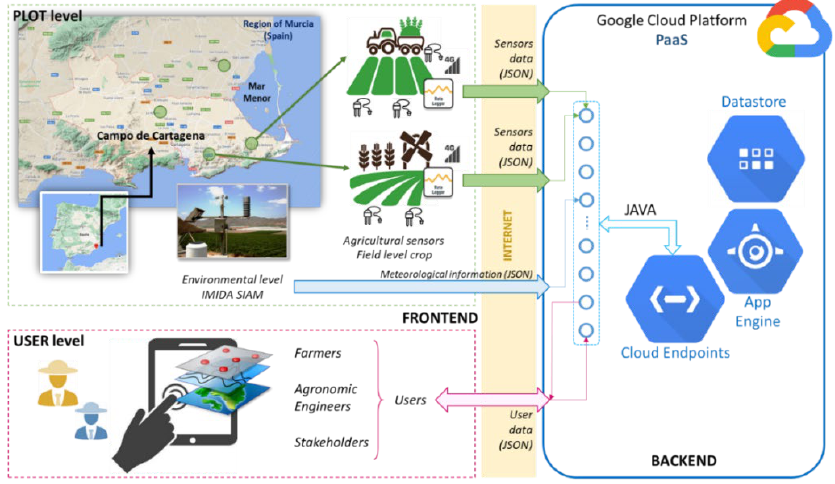
Figure 1. Global architecture of the Irriman Platform. The frontend consists of two levels: PLOT and USER. The backend is implemented as a set of modules running on the Google Cloud Platform. Data loggers acquire information from agricultural sensors and send them to the backend by using the HTTPS protocol and JSON messages as payload. Users could interact with the backend through a WEB application that sends and receives JSON messages by also using the HTTPS